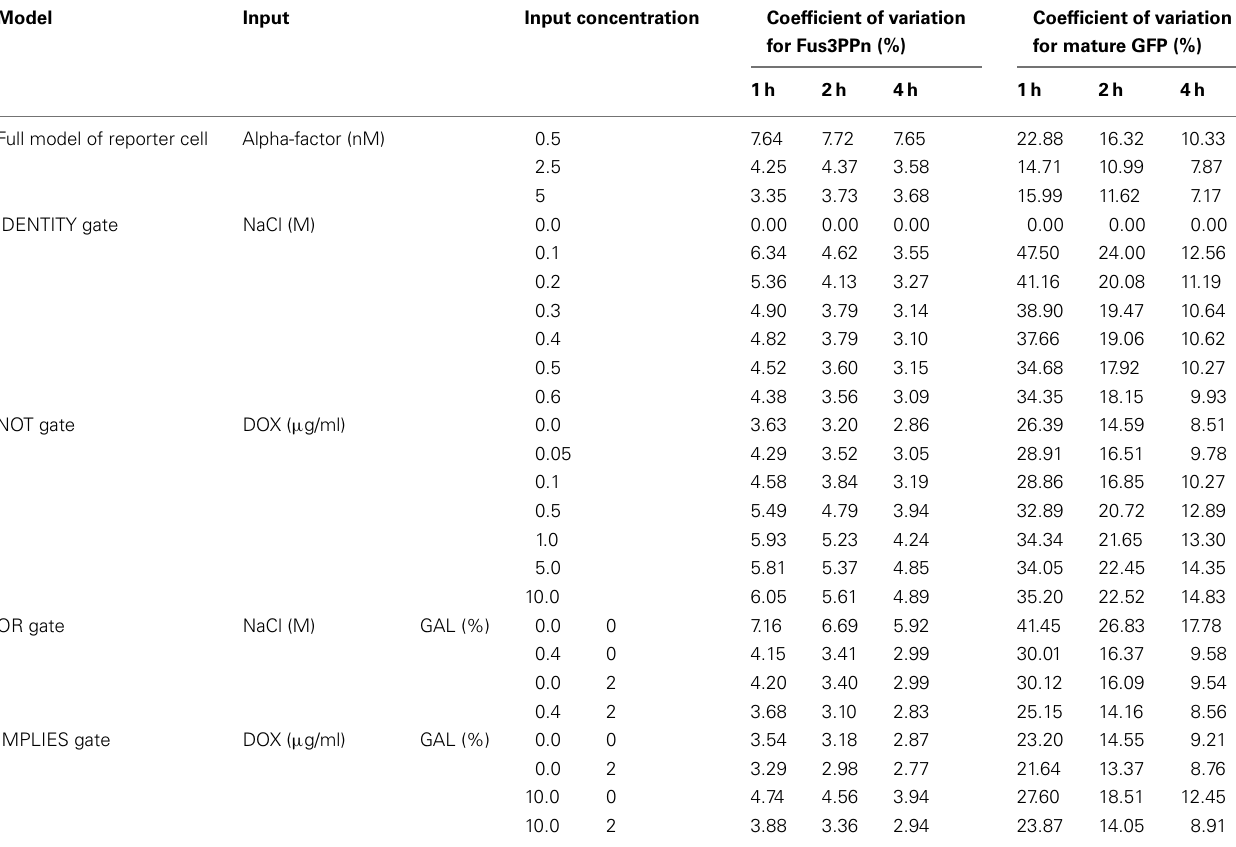
Table 5 | Quantification of cell-to-cell variation in the logic-gate